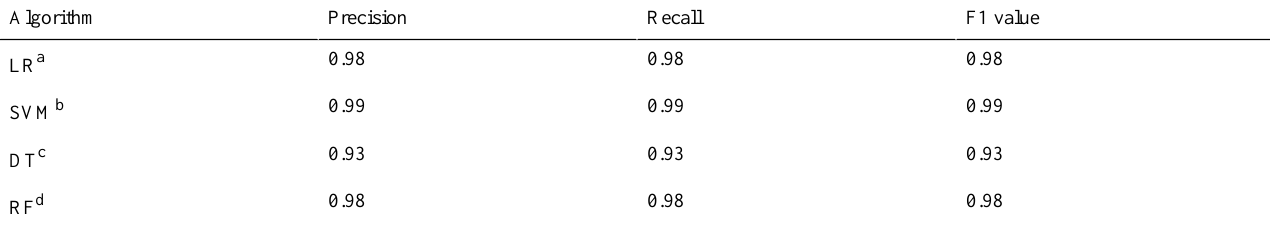
Table 3. Experimental results of common machine learning